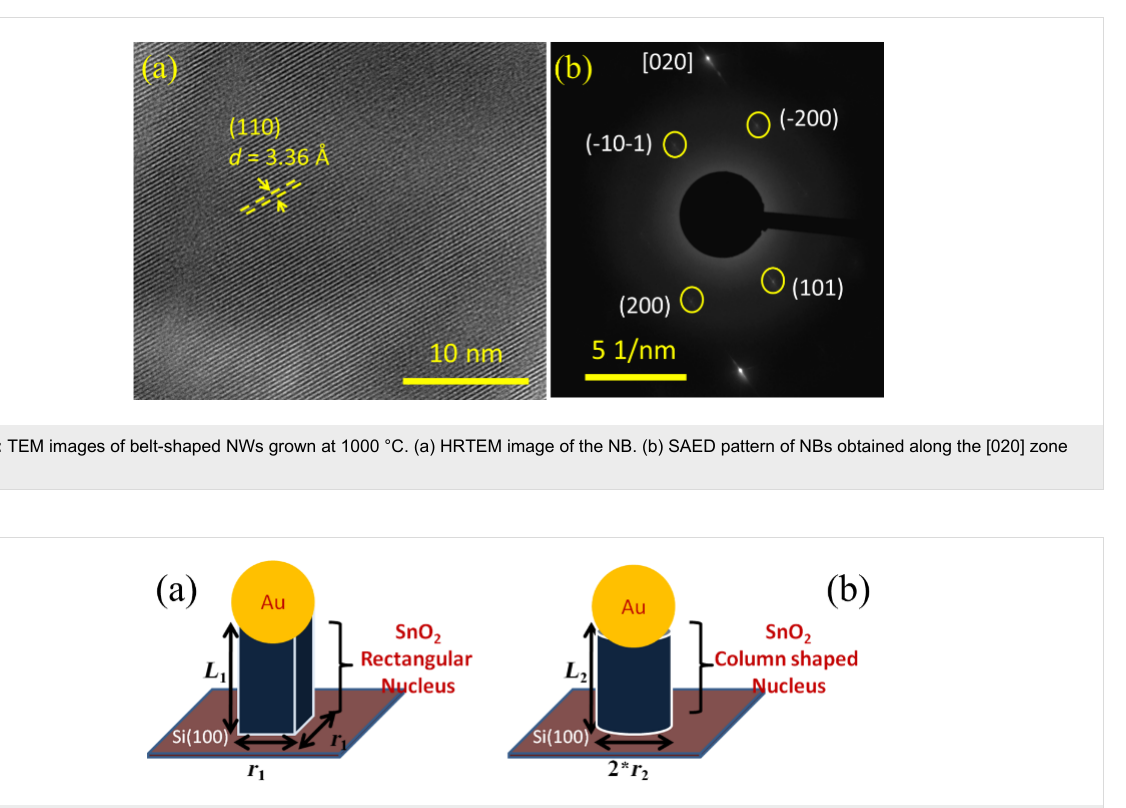
Figure 5: Schematic of the VLS growth mechanism for (a) square and (b) cylinder shaped